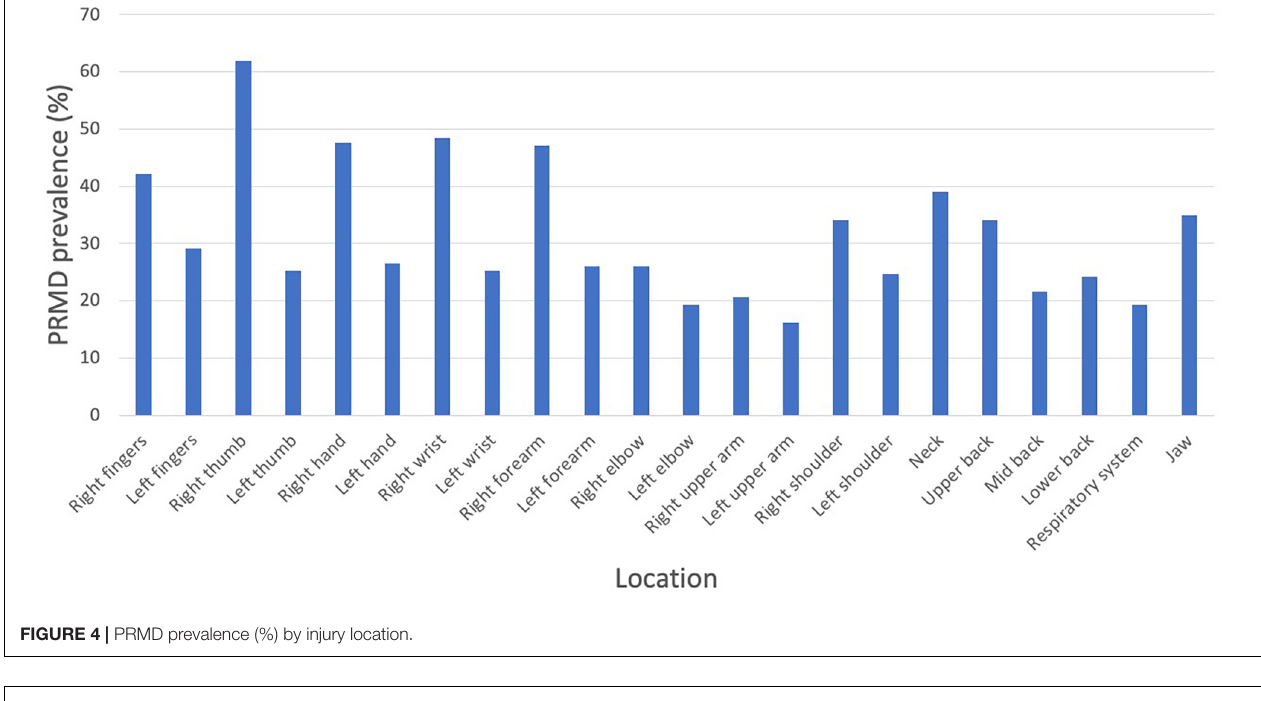
FIGURE 4 | PRMD prevalence (%) by injury location.